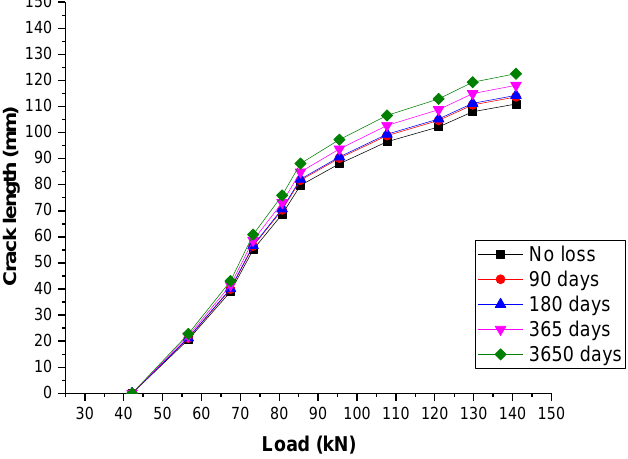
Figure 8. Effect of shrinkage in terms of load-crack length response.